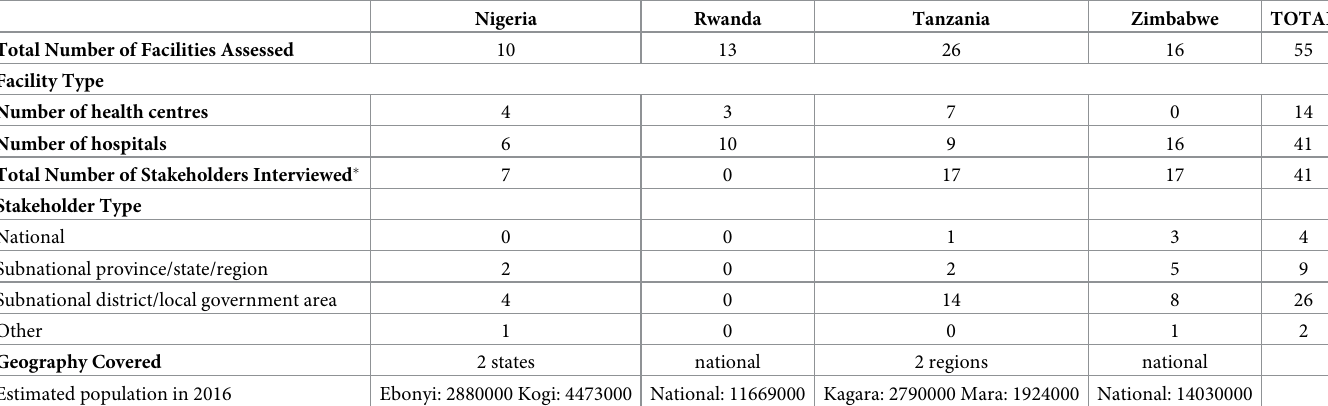
criteria: provision of childbirth services and current or previous experience conducting mater- nal and/or perinatal death audits. Facilities were based on a convenience sample rather than a true probability sample and differed between countries with respect to geographic spread and levels of care. For example, two regions (states) were targeted in Nigeria and Tanzania due to MCSP presence in these areas at the time of the assessment, whereas facilities in all major geo- graphic areas were targeted in Rwanda and Zimbabwe. In total, 55 health facilities (41 hospitals and 14 health centres) received onsite visits. Table 2 summarises the geographic distribution and types of facilities and subnational stakeholders selected in each country. Table 2. Summary of facility and stakeholder samples. Nigeria Rwanda